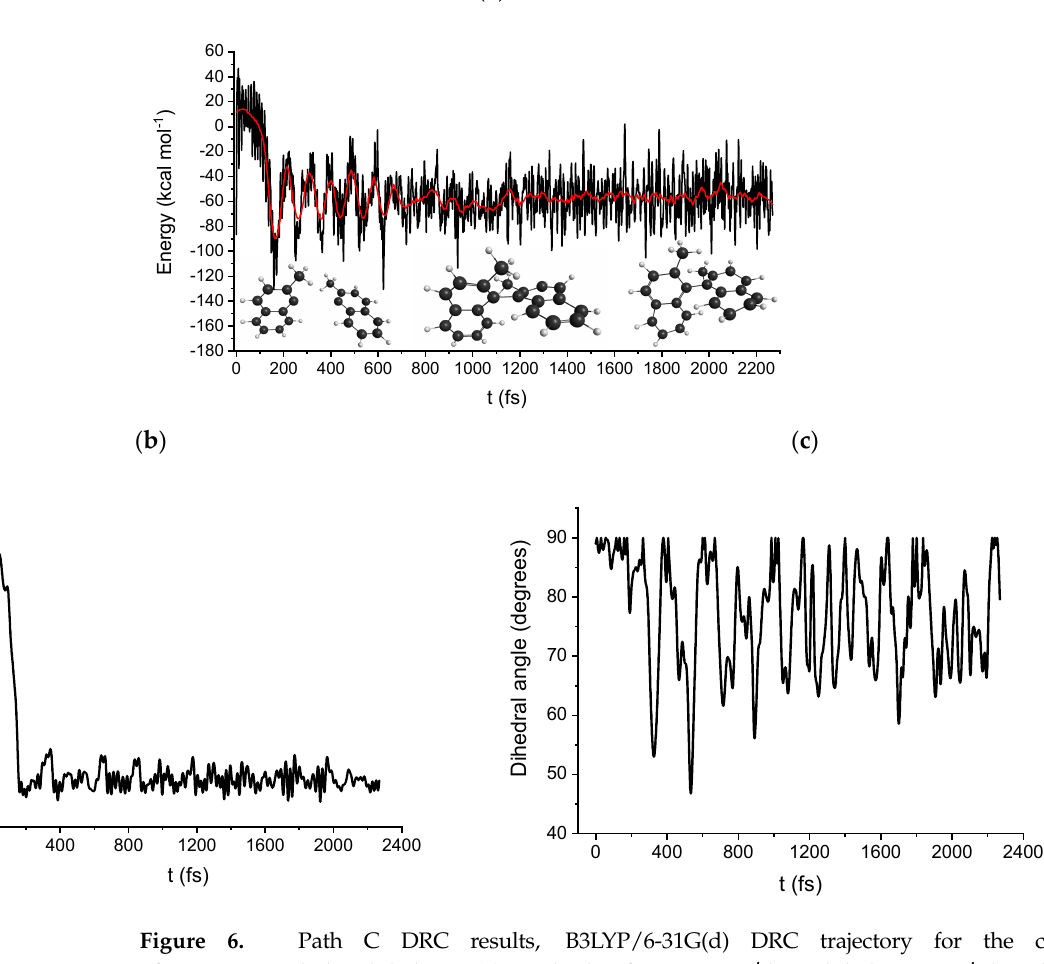
Figure 6. Path C DRC results, B3LYP/6-31G(d) DRC trajectory for the coupling of two 1-methylnaphthalene ( 3 ) radicals forming 1,1 ′ -binaphthalene, 2,2 ′ -dimethyl ( 4 ). ( 𝟑 ) (cid:3080)∙ + ( 𝟑 ) (cid:3081)∙ → ( 𝟒 ). ( a ) molecular electronic potential energy vs. time, ( b ) 𝐶 − 𝐶 bond distance between the two aromatic rings as a function of time, ( c ) dihedral angle between the dissociating 𝐶 − 𝐵𝑟 bond as a function of time.